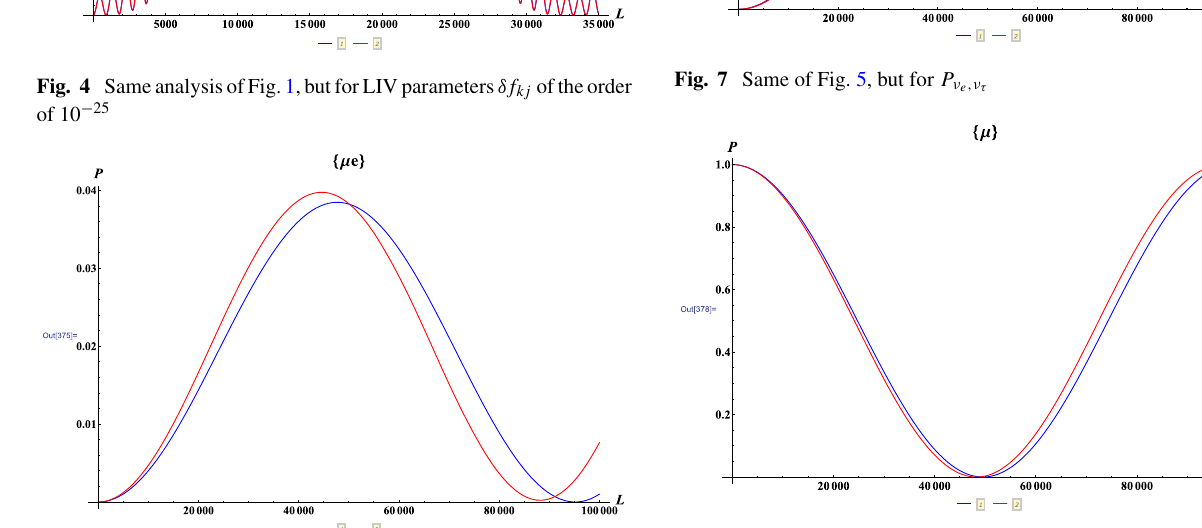
Fig. 8 Totalsurvival probabilityformuonicneutrino, evaluatedforthe same conditions of Fig. 5